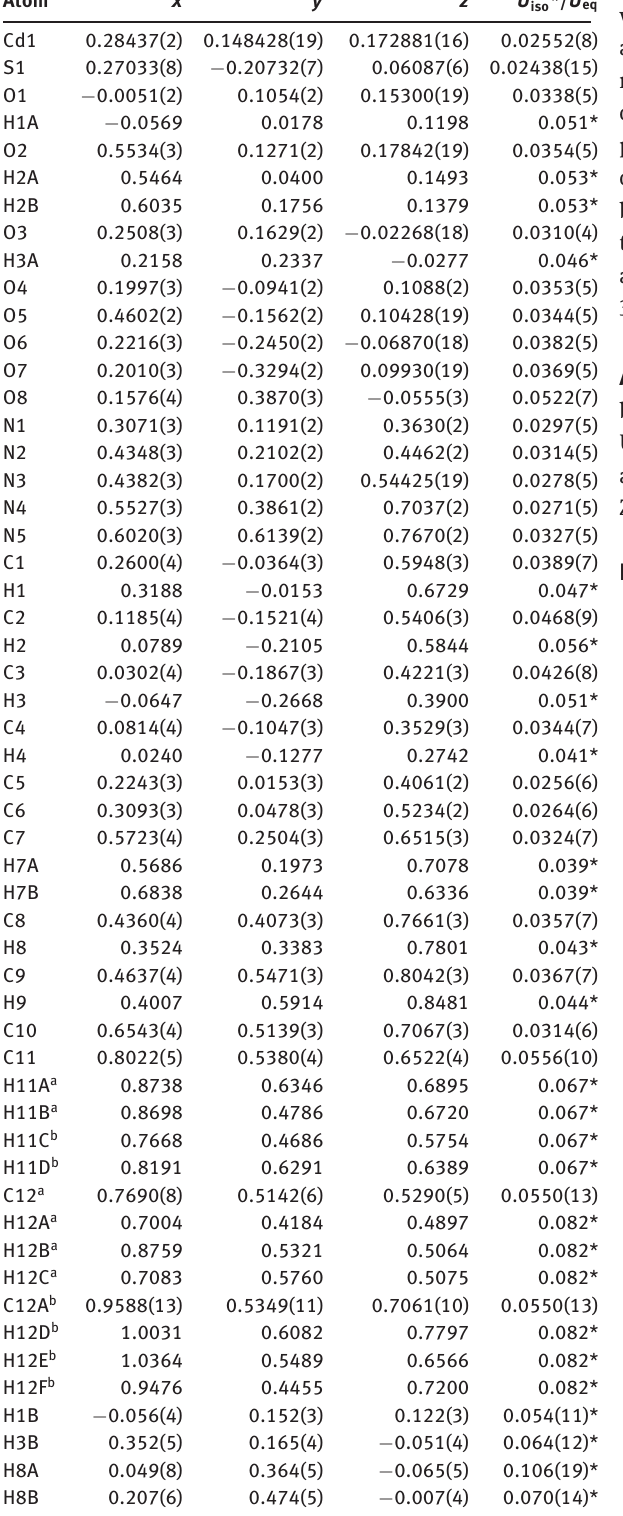
Table 2: Fractional atomic coordinates and isotropic or equivalent isotropic displacement parameters (Å 2